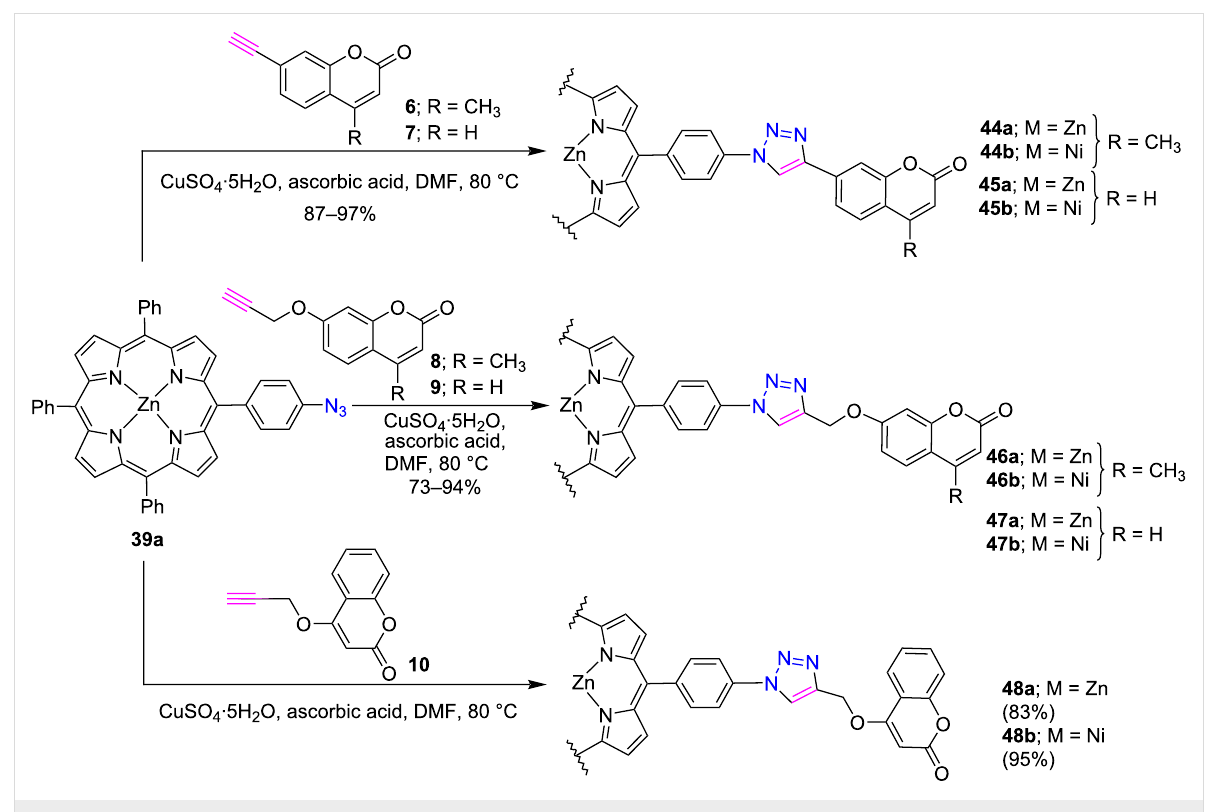
Scheme 8: Synthesis of meso -triazole-linked porphyrin-coumarin conjugates 44–48